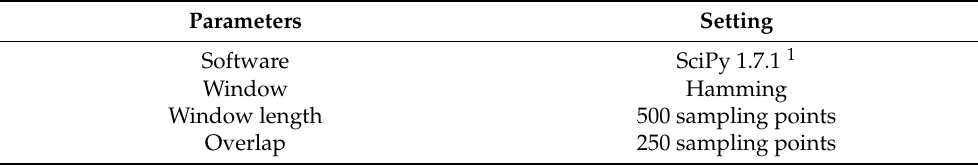
Table 2. Parameters of STFT.